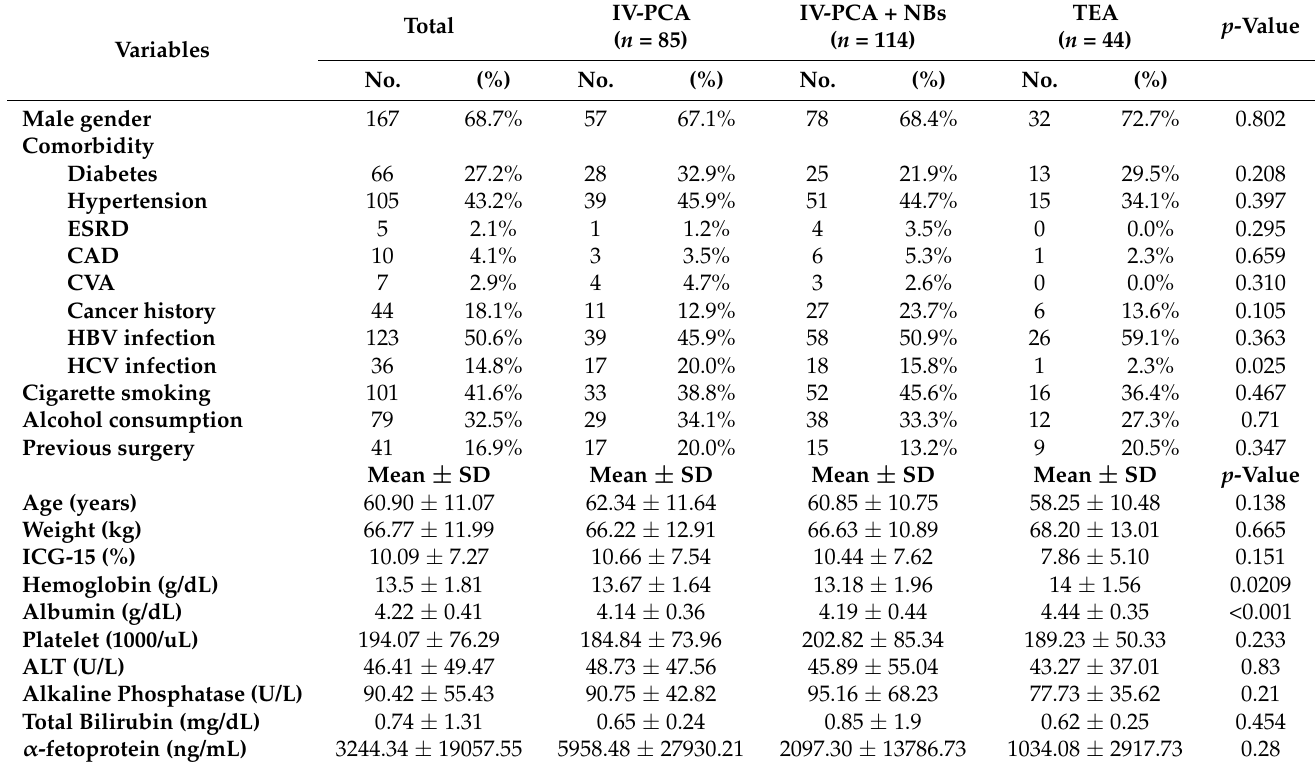
Table 1. Clinical characteristics of patient ( n = 243).